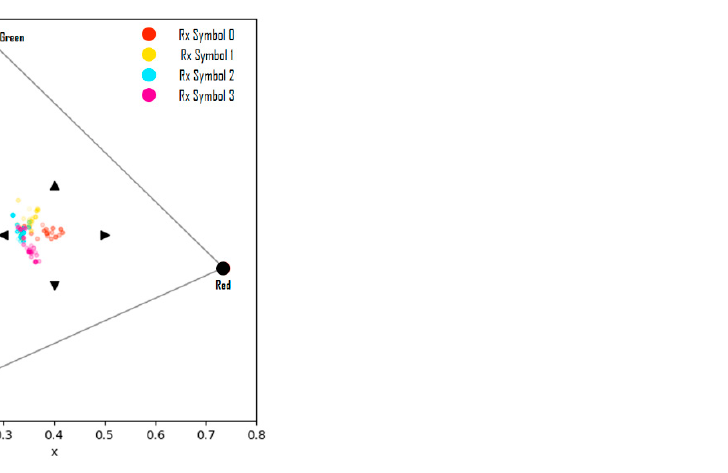
Figure 11. Symbol transmission/reception simulation results from channel modeling. ( n s ≤ − 0.2).